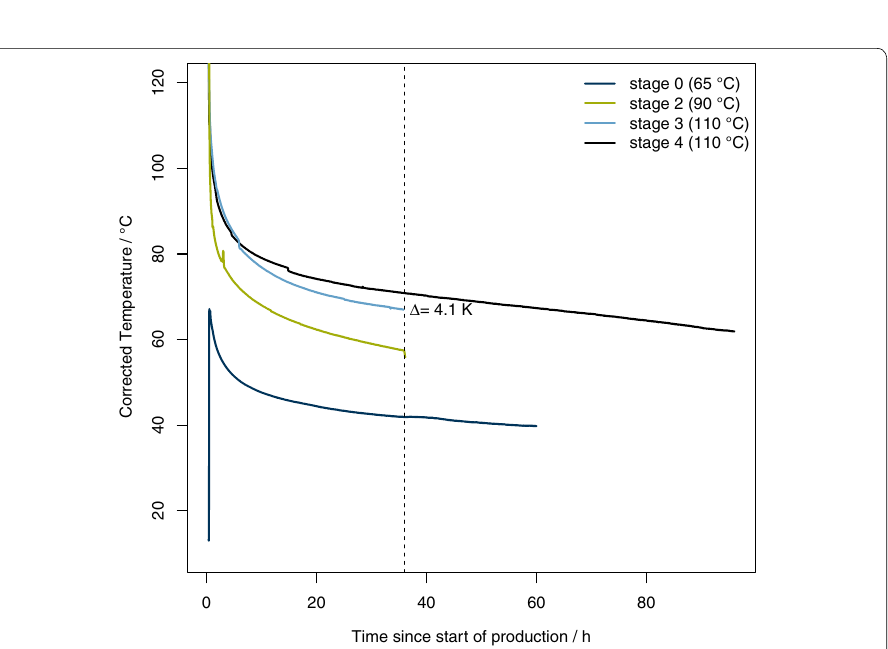
Fig. 15 Development of the corrected temperatures during production stages 0–4 (corrected by fitted sodium ion